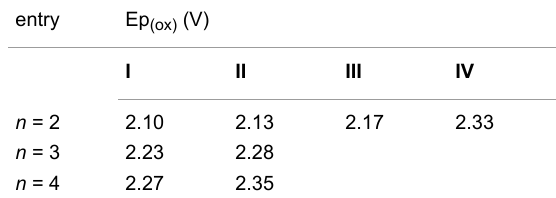
Table 1: Oxidation potentials of α , ω -bisamides (Scheme 7) measured by cyclic voltammetry a